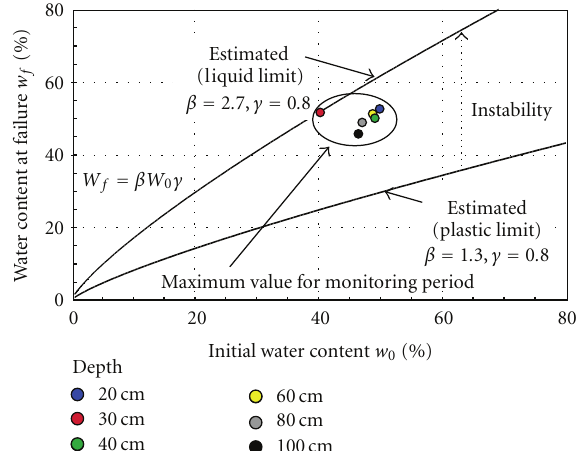
Figure 18: Relationship between water contents at initial w 0 and at failure w f for monitoring site in Date, Hokkaido (using soil moisture meter